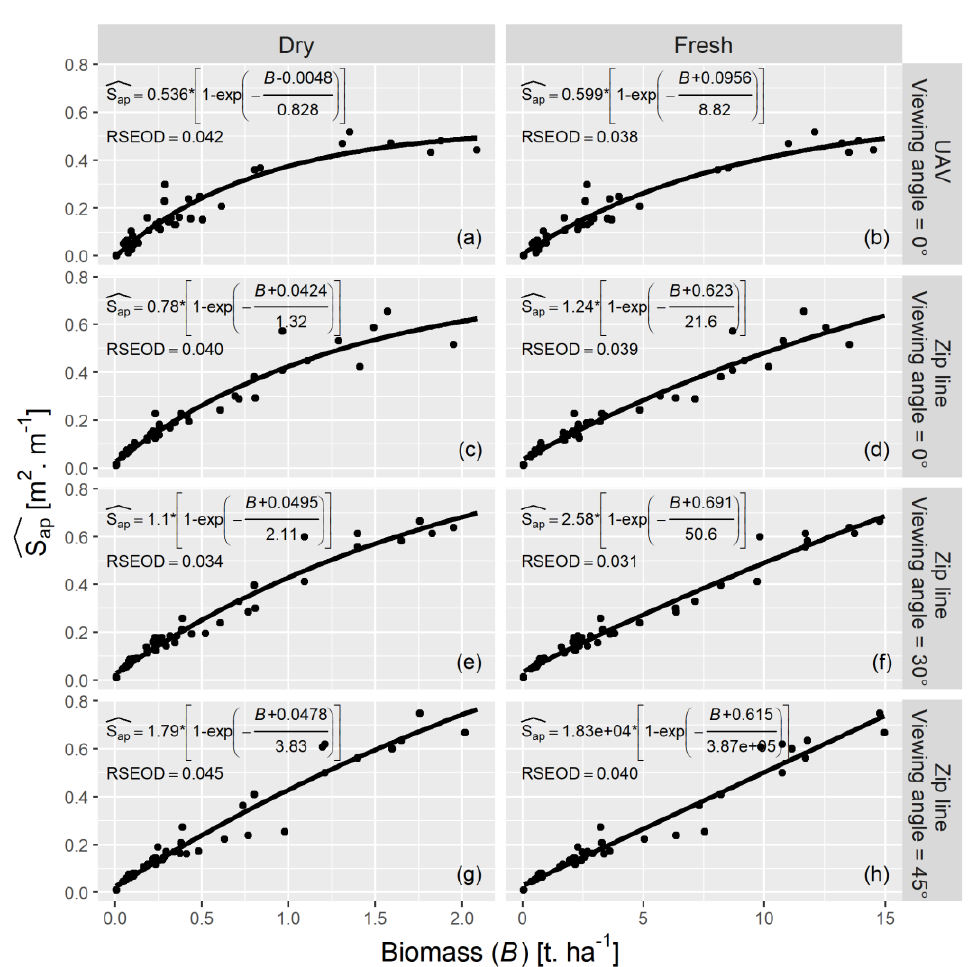
Figure 7. Asymptotic regression models for the apparent surface area of plants as a function of dry (left) and fresh (right) biomass, at different viewing angles: nadir (0°) for UAV ( a , b ) and zip line ( c , d ); 30° ( e , f ) and 45° ( g , h ) for zip line.